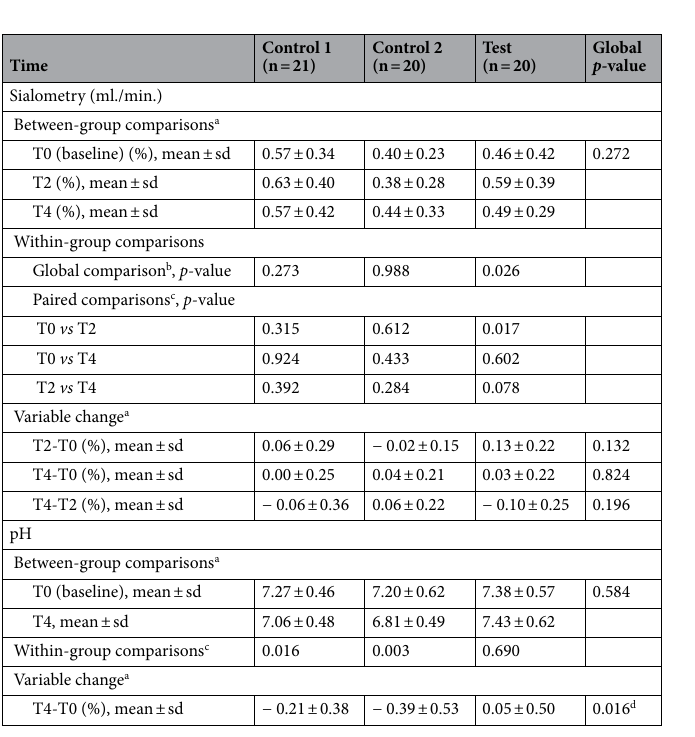
Table 4. Salivary flow and pH results over time in three study groups: baseline, 2-month, and 4-month follow-up. a ANOVA was used for between-groups and variable change comparisons (three groups). If p -value < 0.05, post-hoc paired comparisons (with Bonferroni’s method) were also performed (depicted in footnote d). b For intra-group comparisons (three times), Friedman’s test was used. c Student’s T-test for paired samples. d Post-hoc paired comparisons for independent groups: Significant difference between Test